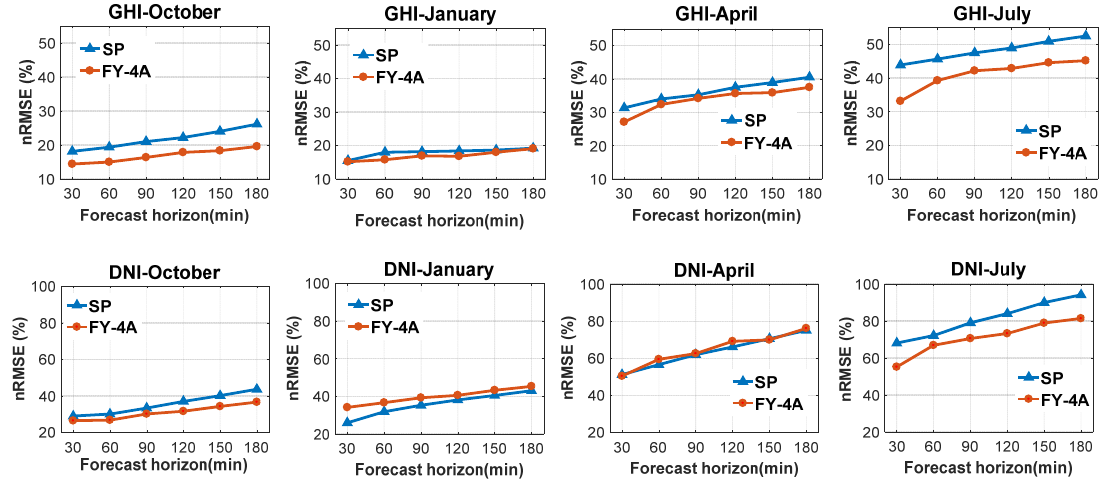
Figure 5. The nRMSE values of forecasting models for GHI ( top ) and DNI ( bottom ) in various forecast horizons in four typical months (October 2018; January, April, and July 2019).